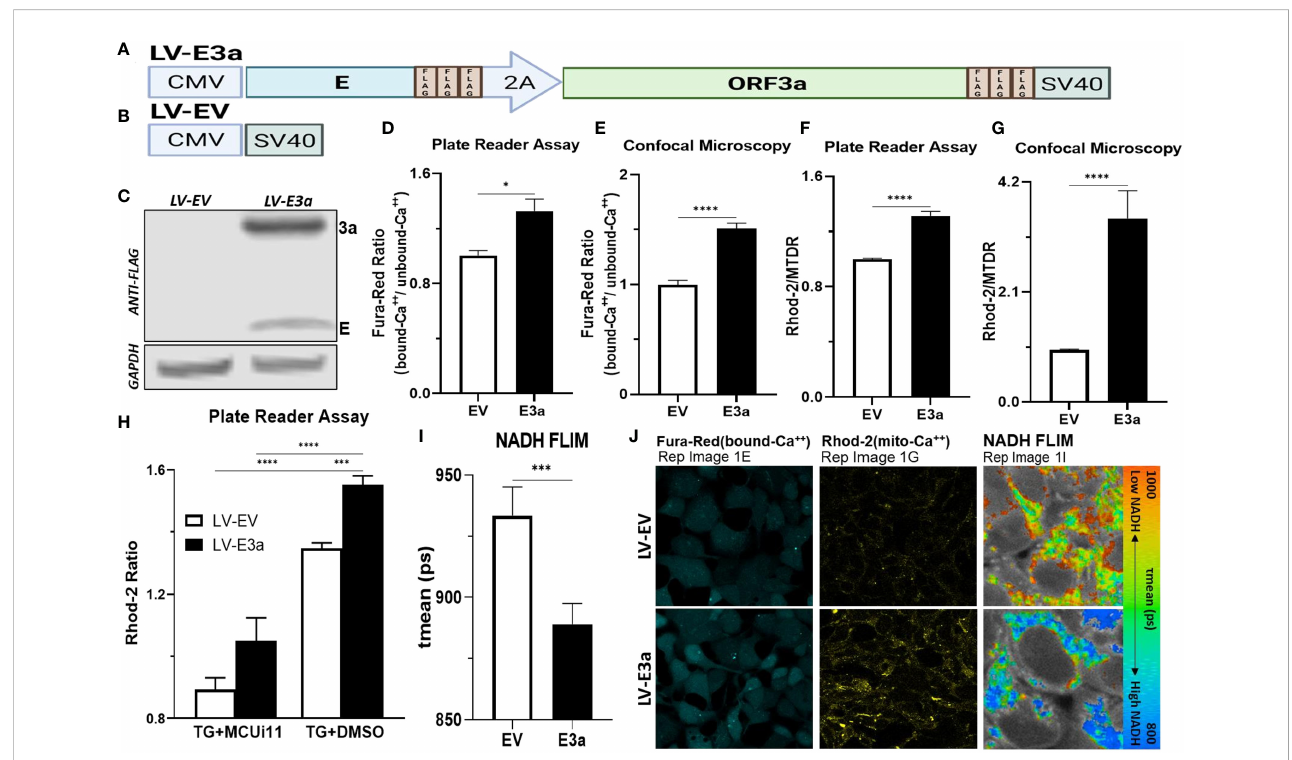
FIGURE 1 Expression of 2-E+2-3a induces mROS production by elevating mitochondrial Ca ++ levels. (A, B) Schematics of our LV-EV and LV-E3a vectors. (C) 293T cells were transduced with LV-EV or LV-E3a, and samples analyzed by immunoblot with a mouse monoclonal antibody against FLAG-Tag, to detect the FLAG-tagged 2-E+2-3a viroporins. GAPDH was a loading control. (D, E) 24 hrs post-transduction cells were stained with Fura-Red to measure cytosolic Ca ++ levels, (F, G) and with Rhod2 & Mitotracker Deep Red (MTDR) to measure mitochondrial Ca ++ levels . (E, G, J) data from confocal microscopy or (D, F) data from plate reader assays. (H) 24 hrs post-transduction with LV-EV or LV-E3a 293T cells were treated with or without 10 m M MCUi11, and then 2.5 m M TG and stained with Rhod2 to measure mitochondrial Ca ++ levels by plate reader assays. (I) Cells, 24 hrs post-transduction with LV-EV or LV-E3a, were analyzed for mean mitochondrial NADH lifetime (t mean ) indicating (NAD + /NADH ratio) using FLIM. (J) Representative images of Fura-Red, Rhod2- stained, and NADH lifetime imaged cells. Scale bar = 30 m m. Error bars represent SEM from 3 independent experiments; statistically signi fi cant data is indicated with asterisks